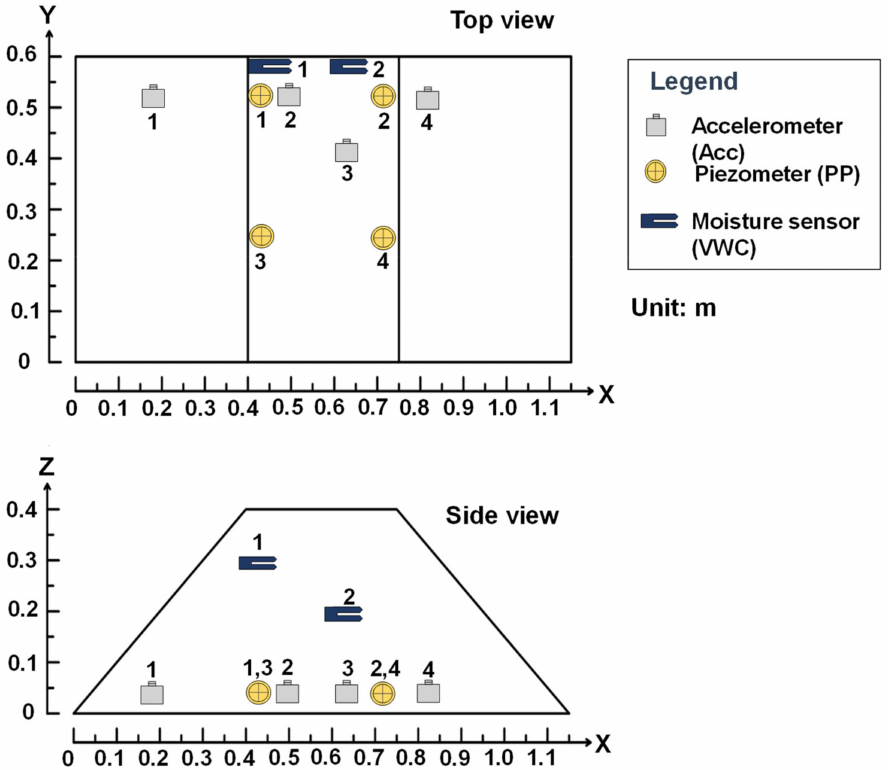
Figure 3. Sensor configuration in the dam model (the numbering of the sensors is marked near each